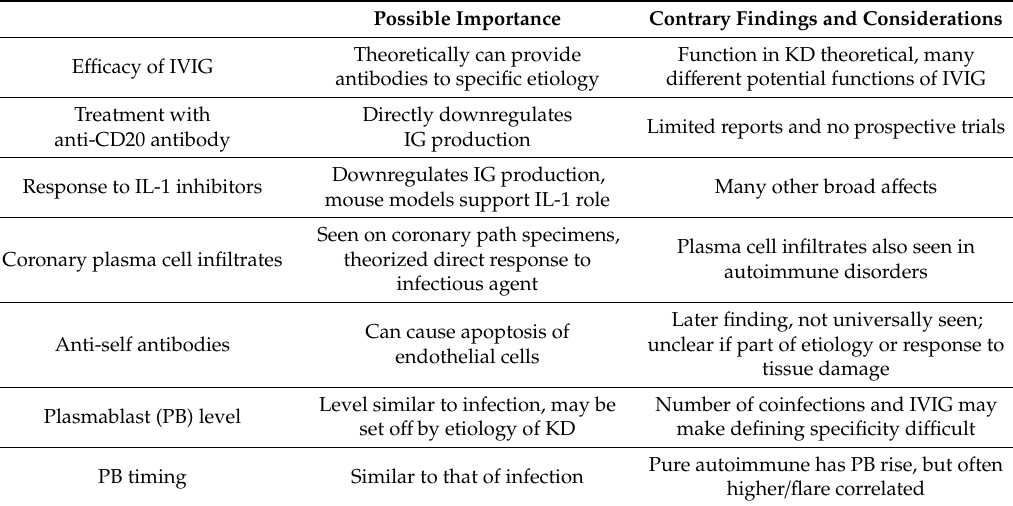
Table 3. Possible ways humoral immunity plays a role in